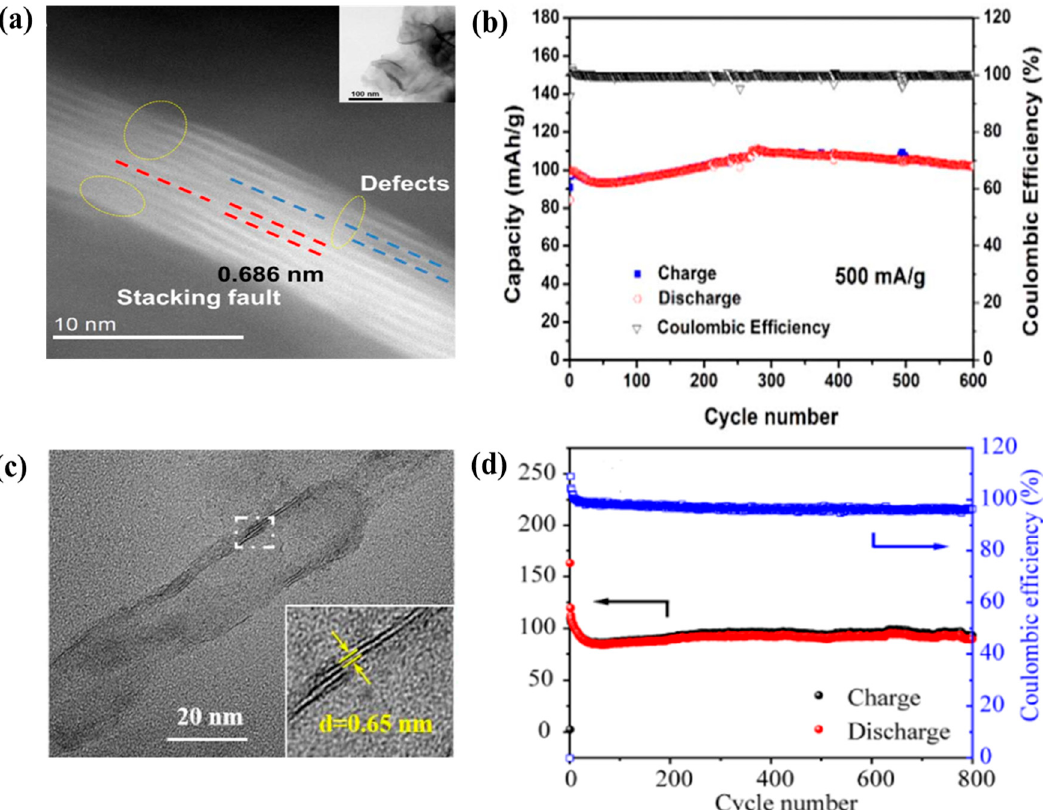
Figure 6. ( a ) TEM image of defect-rich MoS 2 nanosheets, ( b ) cyclic performance of defect-rich MoS 2 nanosheets at 200 mA g − 1 . Reprinted with permission from Xu et al. [79] Copyright 2018, Elsevier B.V. ( c ) TEM image of tubular MoS 2 , ( d ) cyclic performance of tubular MoS 2 at 500 mA g − 1 . Reprinted with permission from Yang et al. [80] Copyright 2020, ESG Publi- cation.